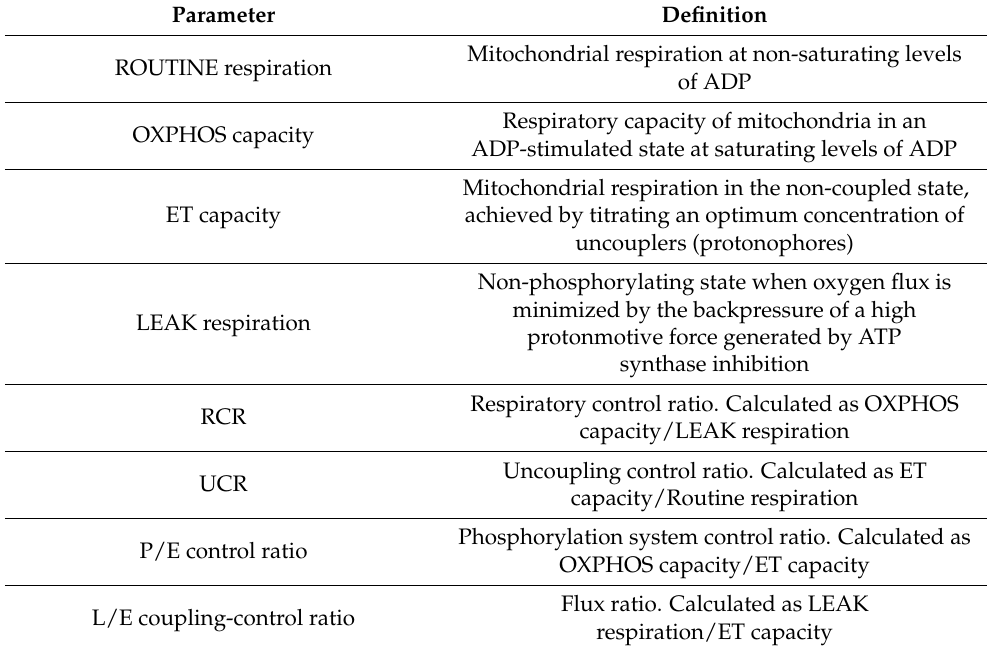
Table 1. Respirometry parameters and some control ratios assessed by HRR